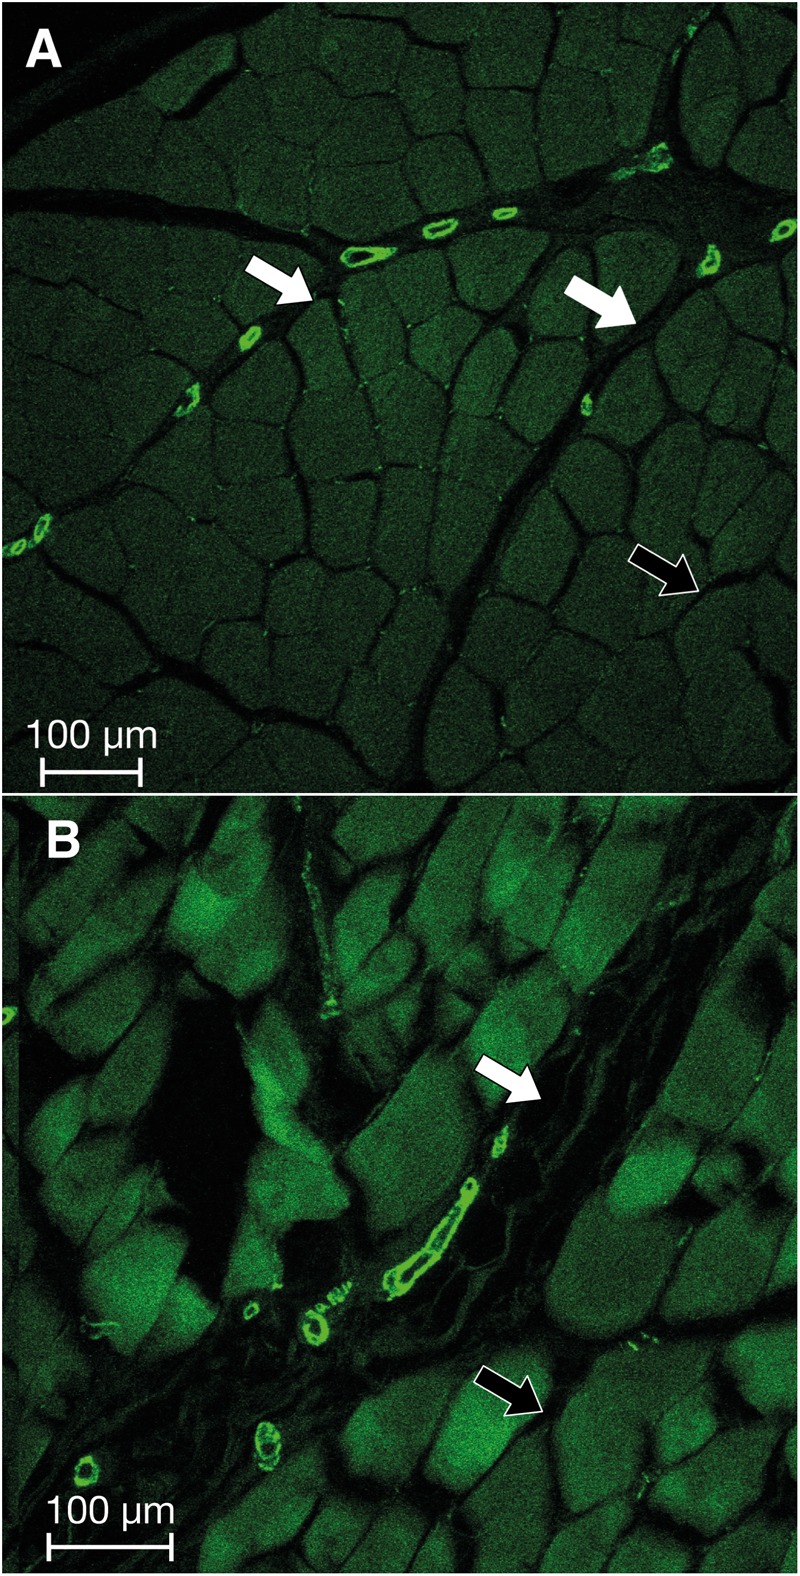
Immunofluorescence imaging of two representative sections of intramuscular fascia from the human lumbar region. Bright green: elements that are positively stained for the presence of ASMA. Note the apparently increased presence of MFBs in the perimysial zones (white arrows) as opposed to endomysial zones (black arrows) in both sections (A,B).